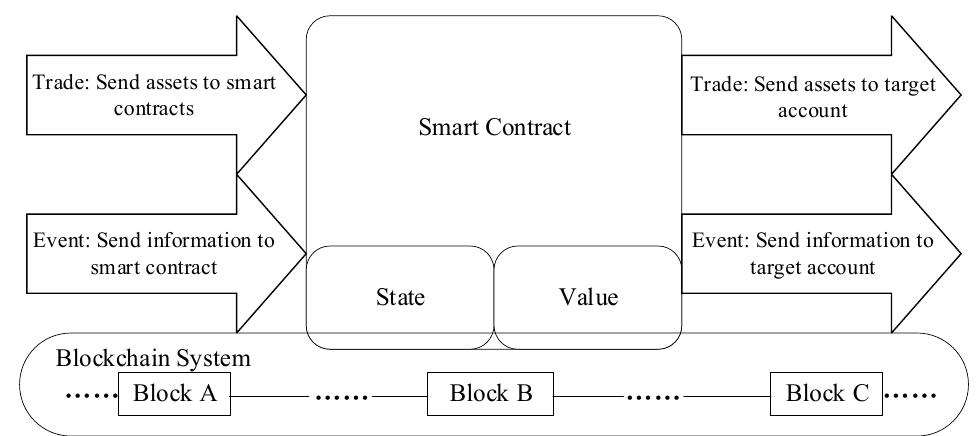
Figure 2. Smart contract model.